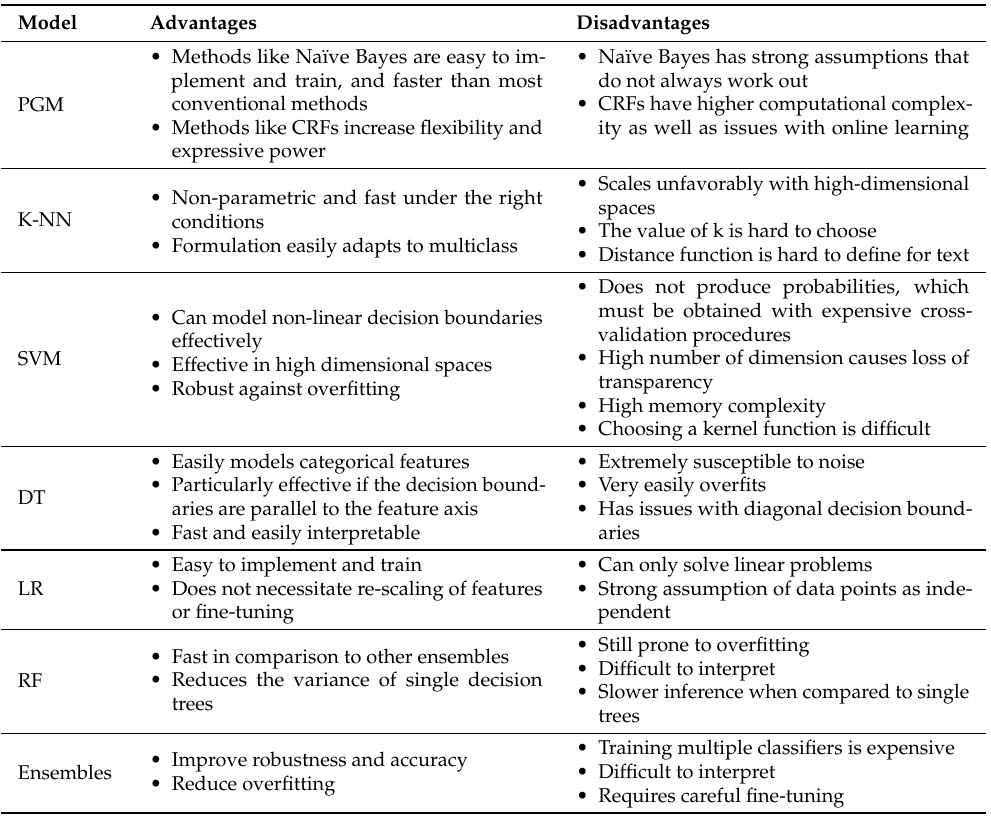
Table 2. Conventional shallow classification